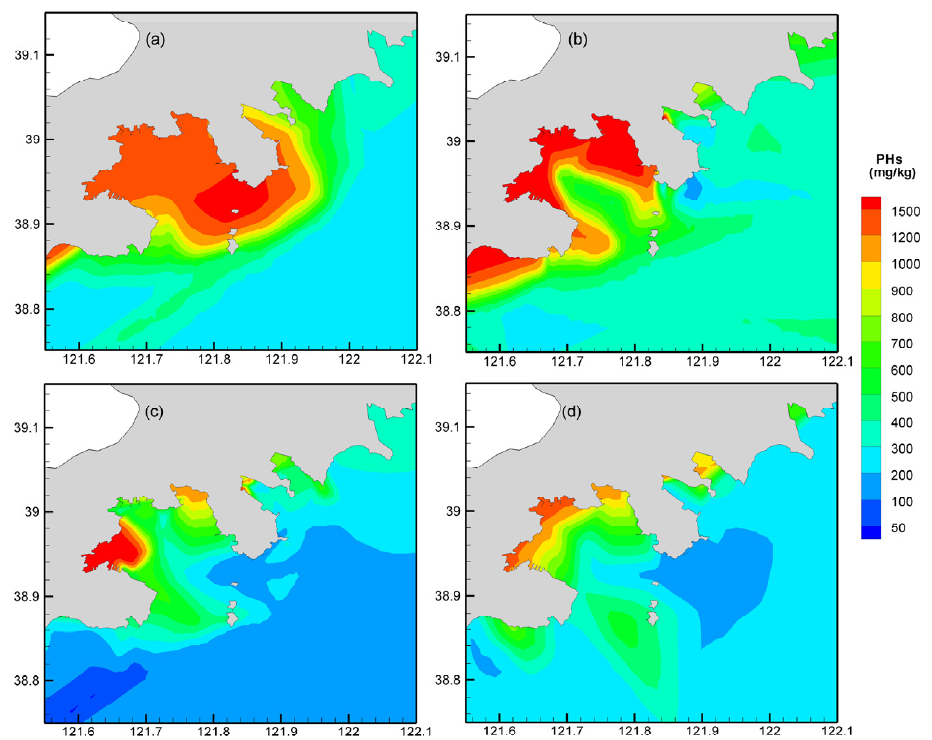
Figure 7. Spatial distribution of PHs in bed sediment in different years, ( a ) September 2010, ( b ) September 2015, ( c ) December 2010, and ( d ) September 2021. Sediments are kept in suspension due to the presence of turbulent fluctuations until the sediment carrying capacity decreases. Most of sediments directly enter the head of Dalian Bay and are deposited in nearshore areas under the action of wind-driven and tidal currents. The weaker waves and flow intensity in the corner of the bay cause less resuspension and more deposition of sediment. The continuous onshore sediment transport produces a PH accumulation over 1500 mg/kg in Dalian Bay, especially close to the shoreline (Figure 7b). In December 2020, the maximum PH concentration occurred in nearshore sediments at the northwest corner of Dalian Bay, one order of magnitude higher than other subtidal regions (Figure 7c). This was attributed to more than one PH source in this zone. Even before DLNPOS, background PH concentrations were quite high due to anthropogenic emissions and the low self-purification ability of environment. Large waves lead to increased suspended sediment concentration during windy periods and cause a redistribution of sediment from high to low pollution areas (Figure 7d). Although these extreme events last for only a few days, they play an important role in the local PH’s re-distribution and